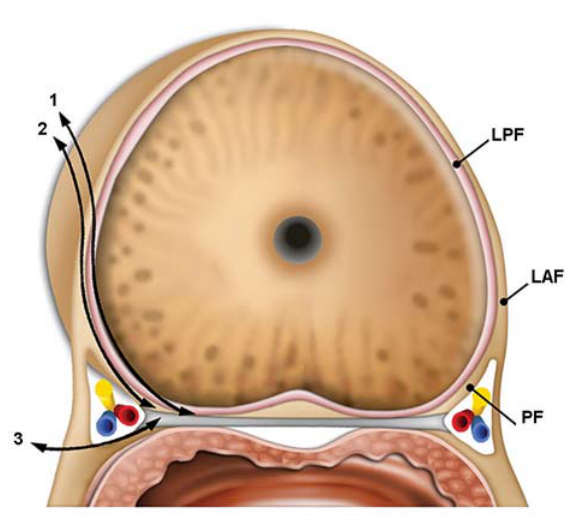
Figure 4 – Neurovascular bundle sparing.